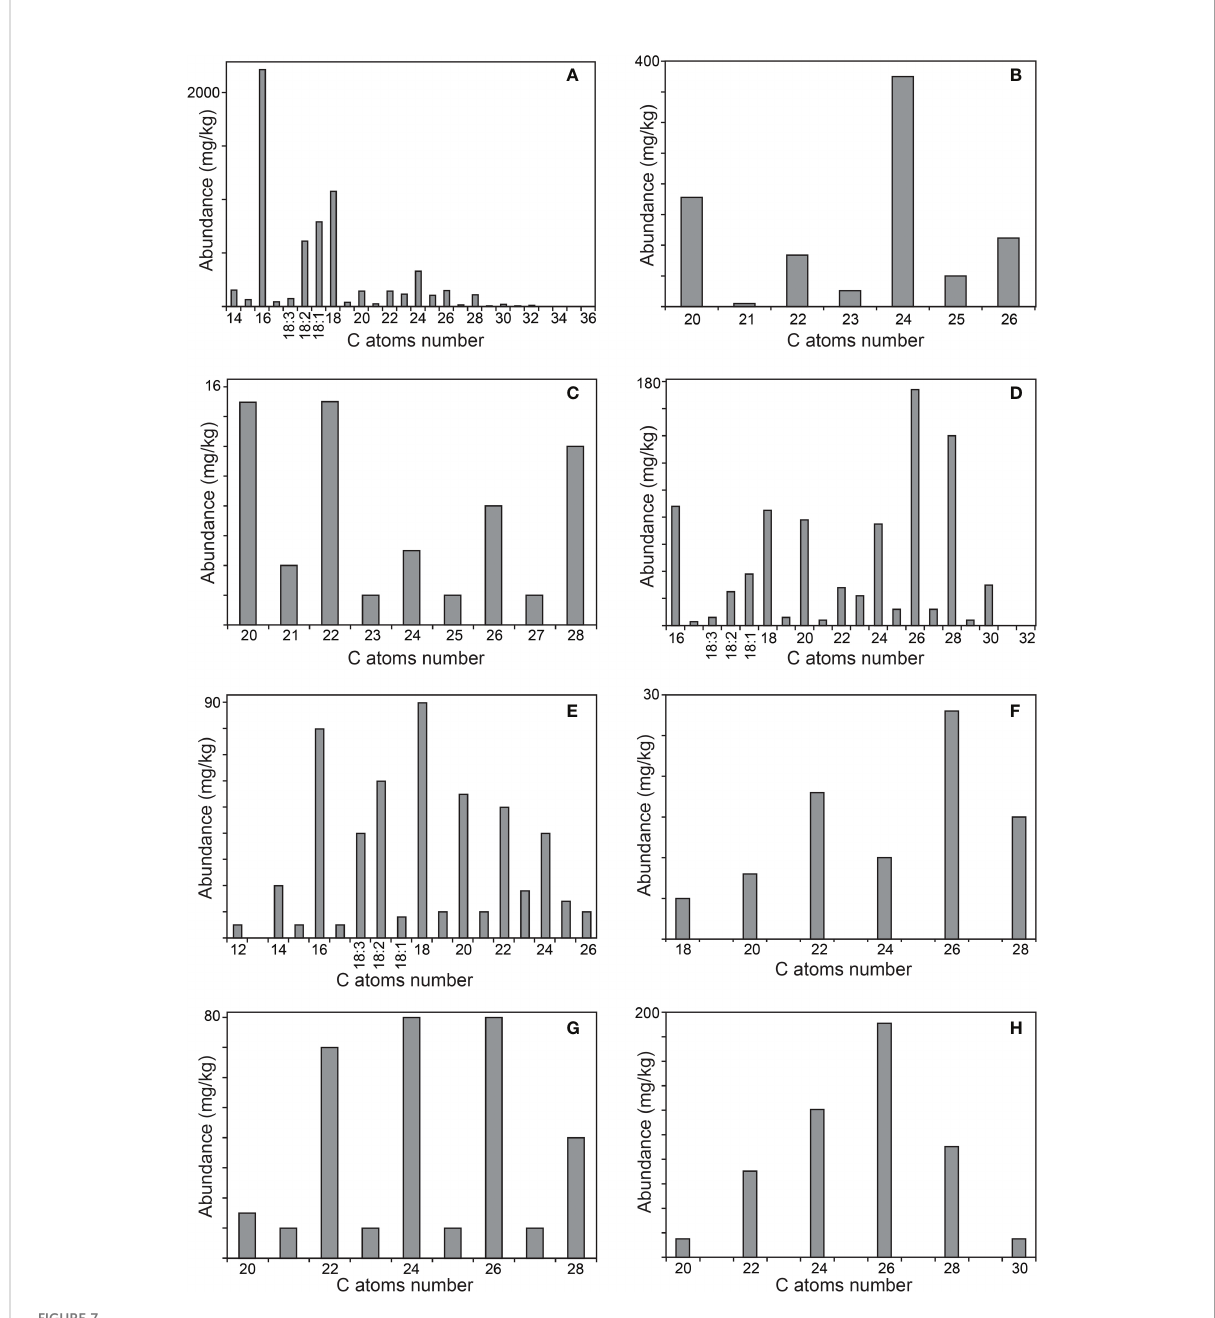
FIGURE 7 Distribution of the main aliphatic series identi fi ed in the acetone extracts of the pith of papyrus stems. (A) n -fatty acids; (B) 2-hydroxy fatty acids; (C) n -fatty alcohols; (D) 1-monoglycerides; (E) phytol esters; (F) alkyl ferulates; (G) w -carboxyalkyl ferulates; (H) monoglycerides of w - carboxyalkyl ferulates. The histograms are scaled up to the abundance of the major compound in the